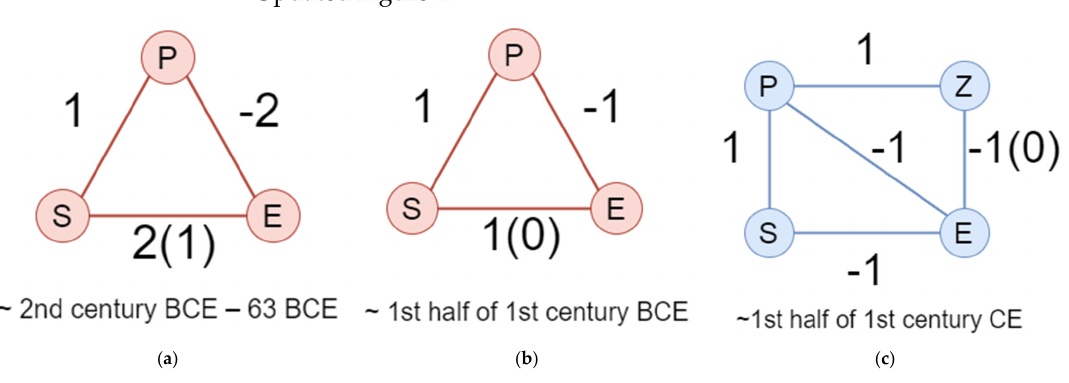
Figure 4. Visualization of the relations between Judaean sects during the period 2nd century BCE–74 CE. The vertices are denoted S (Sadducees), P (Pharisees), E (Essenes), and Z (Zealots). The panels illustrate the relations during different periods: ( a ) the period from the 2nd century BCE to the advent of the Romans in Judea in 63 BCE; ( b ) the first half of the 1st century BCE; ( c ) the period from 6 BCE until 74 CE. Reference 1. Tantlevskij, I.R.; Gromova, E.V.; Gromov, D. Network Analysis of the Interaction between Different Religious and Philosophical Movements in Early Judaism. Philosophies 2021 , 6 , 2. https://doi.org/10.3390/philosophies6010002